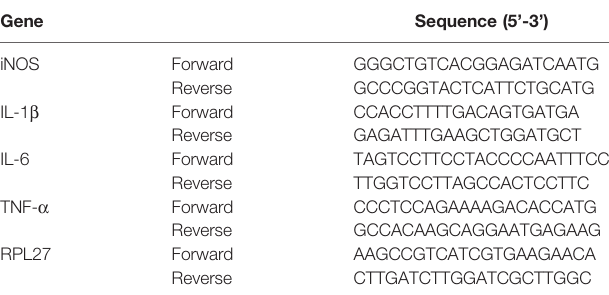
TABLE 1 | Primer sequences of iNOS, IL-1 b , TNF- a , IL-6 and RPL27. Gene Sequence (5 ’ -3 ’ )